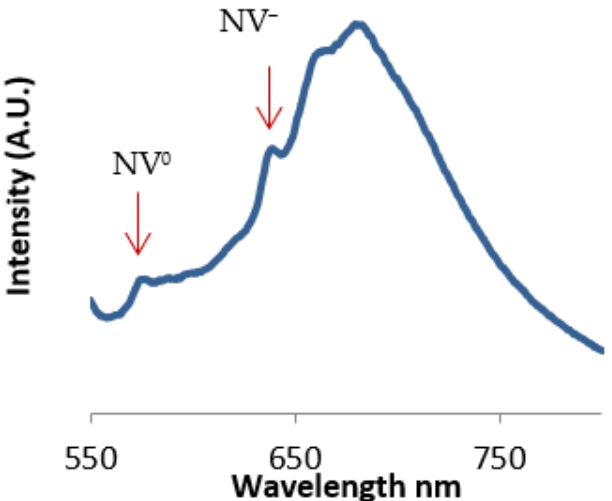
Figure 1. The emission spectrum of nanodiamond and the location of zero phonon lines from both nitrogen-vacancy centers ( λ exc = 532 nm).